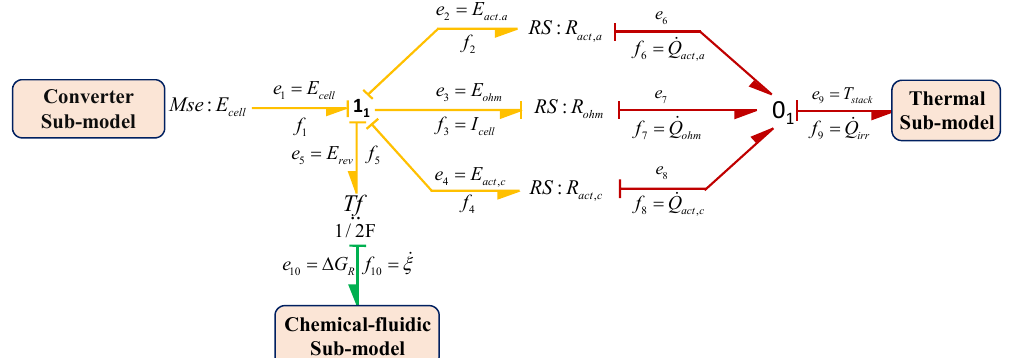
Figure 9. Electrochemical BG sub-model in capsule